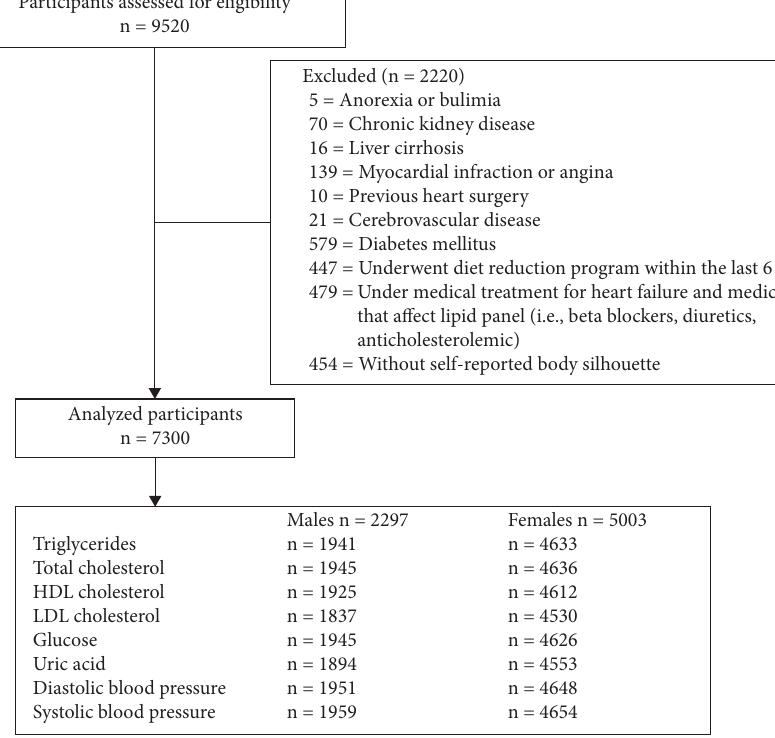
Figure 2: Participants’